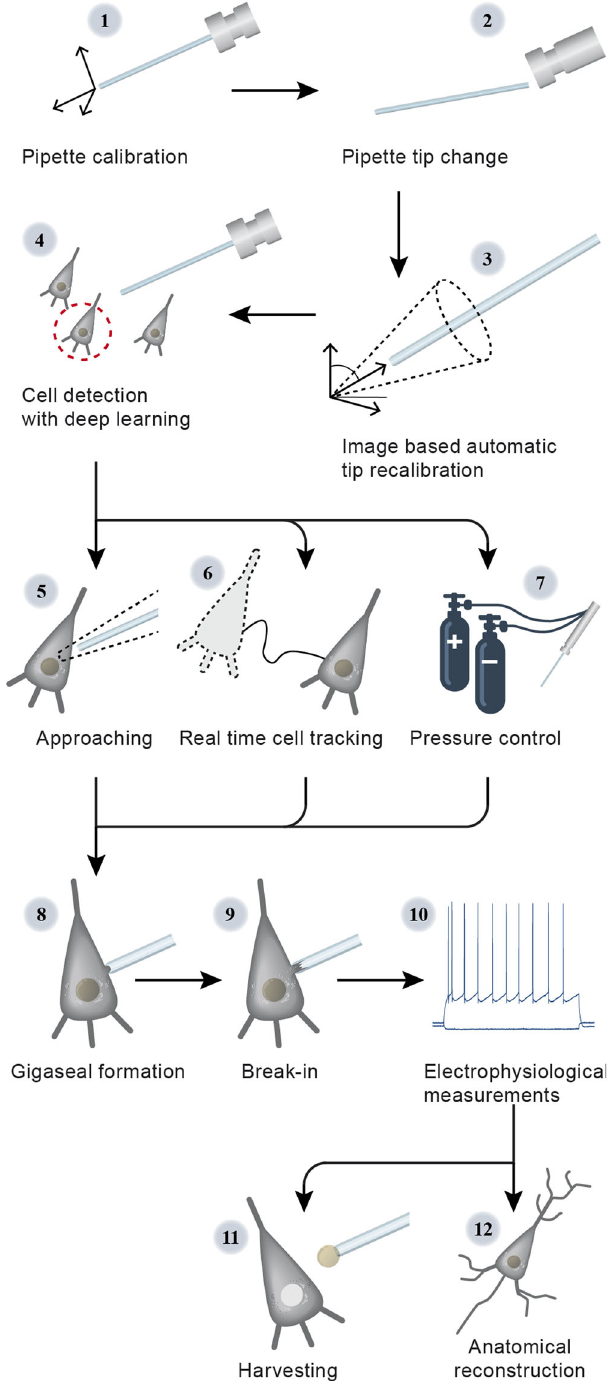
Fig. 1 Steps of DIGAP procedures. 1: Pipette calibration by the user, 2: pipette replacement after recording, 3: image-based automatic pipette tip detection, 4: automatic cell detection, 5: pipette navigation to the target cell, 6: 3D cell tracking, 7: pressure regulation, 8: gigaseal formation, 9: break-in, 10: electrophysiological recording, 11: nucleus and cytoplasm harvesting, 12: anatomical reconstruction of the recorded